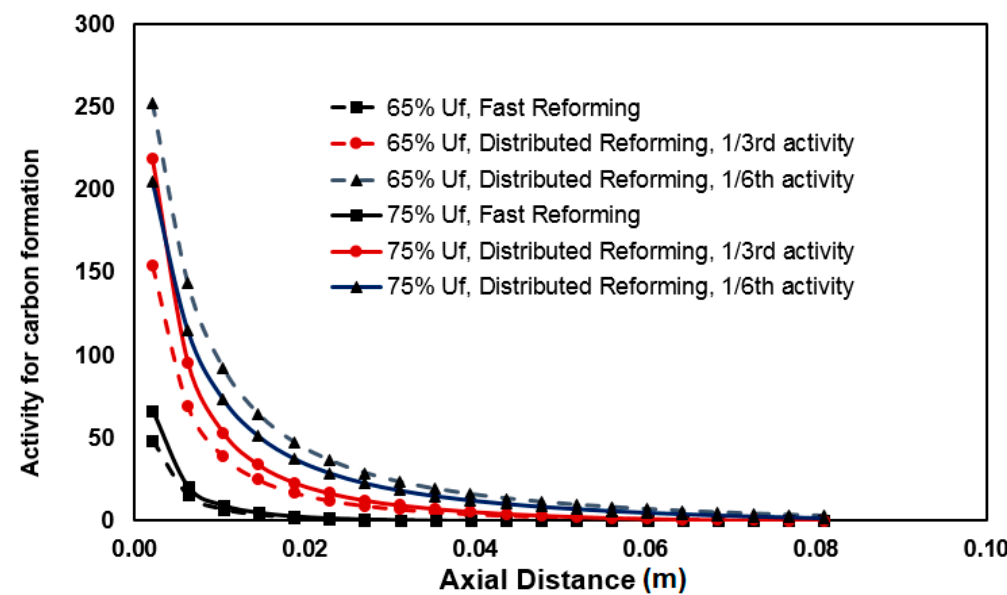
Figure 8. Profile of carbon formation risk from methane cracking for different reforming activity at 65% and 75% fuel utilization.